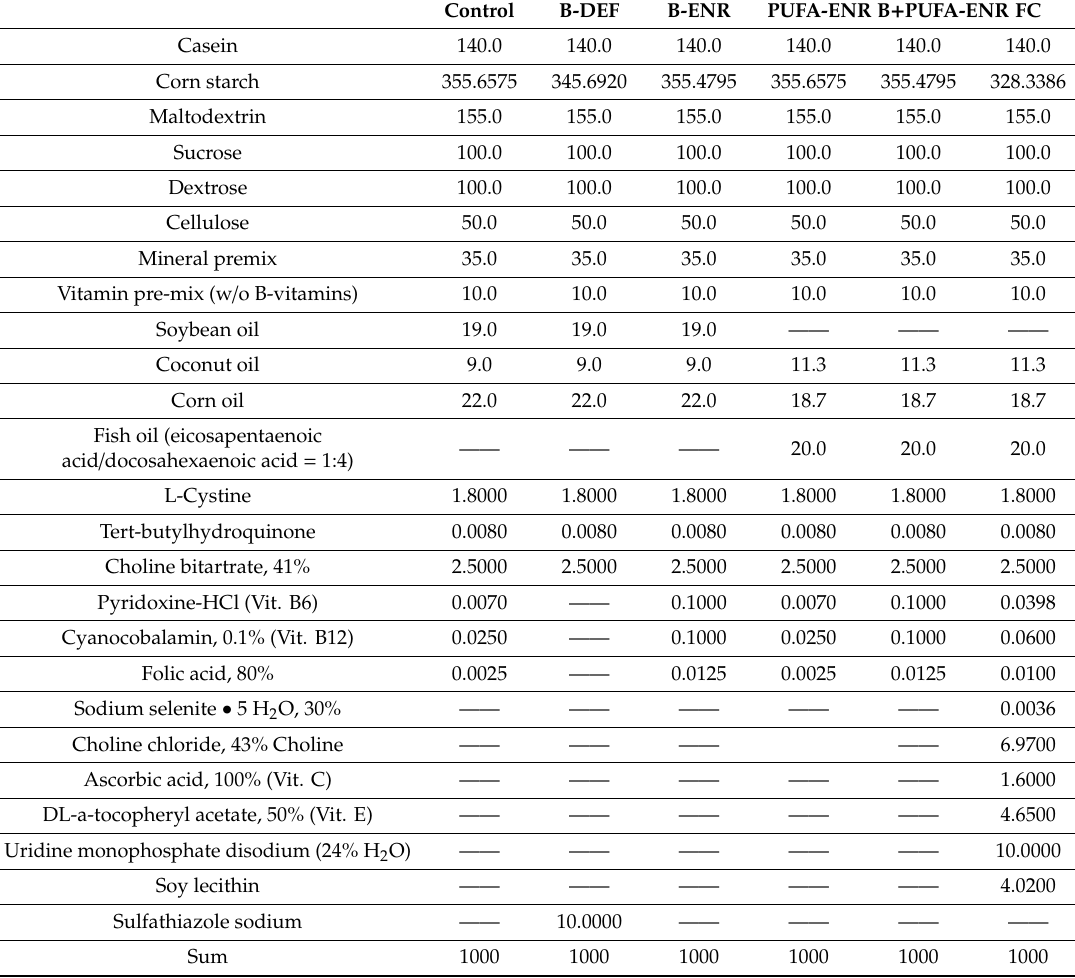
Table A1. Composition of the experimental